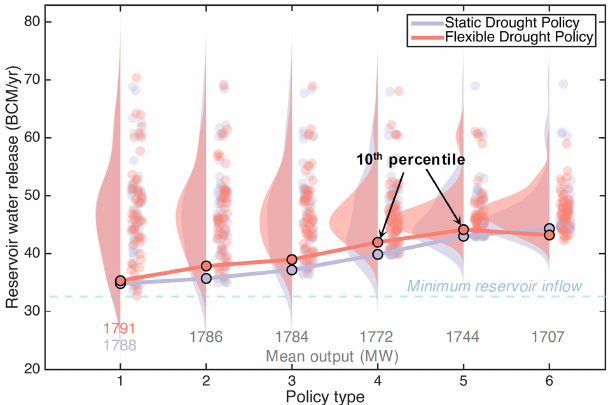
Figure 11. Comparison of reservoir operations using flexible and static drought policies based on power generation output and water release distribution analysis. Policy type 1 refers to the comparison with a similar statistical distribution of water releases. Policy types 2–6 refer to comparisons with similar power generation